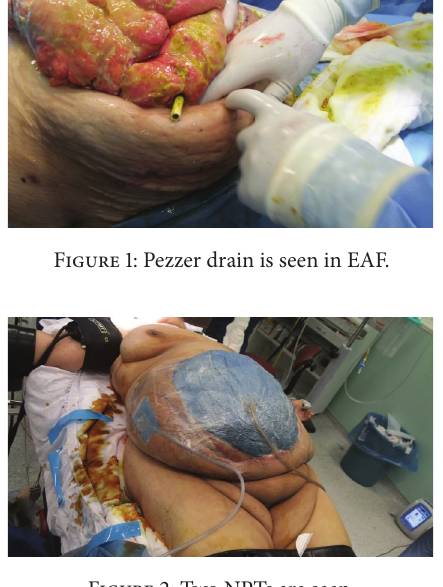
Figure 2: Two NPTs are